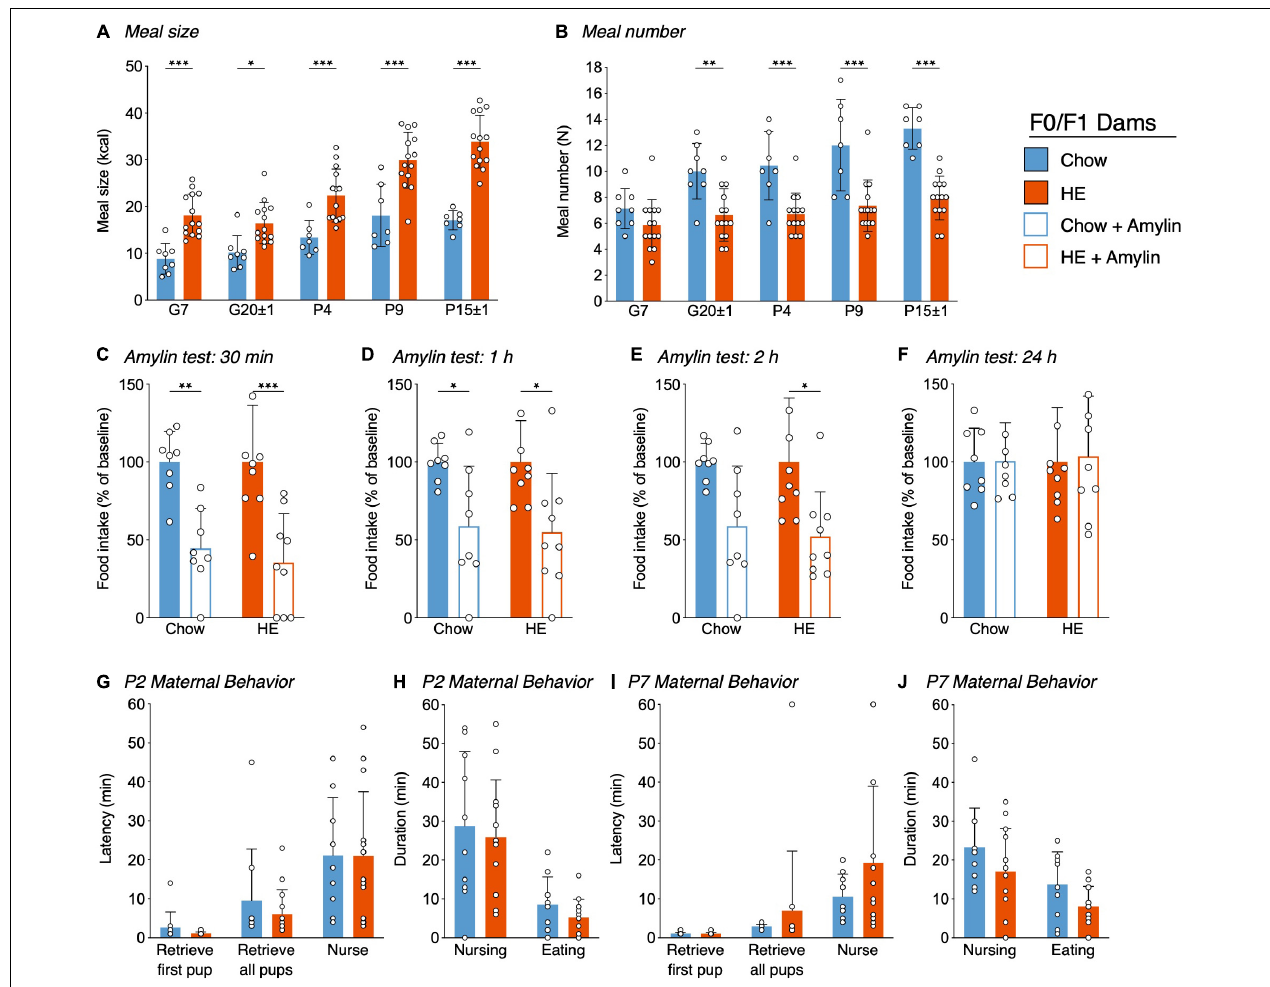
FIGURE 3 | Influence of HE-diet in obesity-prone and -resistant rat dams in filial generation 0 and 1 (F0/F1) on meal pattern, amylin sensitivity, and maternal behavior. Average meal size in kilocalories (A) and meal number (B) of pregnant and postpartum rat dams on chow or high energy (HE) diet on gestational day 7 (G7), G20 ± 1, postpartum day 4 (P4), P9, and P15 ± 1. (C–F) Food intake as percentage of baseline following a single dose subcutaneous amylin (20 µ g/kg) or vehicle (saline) injection in rat dams on gestational day 11 ± 2, 30 min (C) , 1 h (D) , 2 h (E) , and 24 h (F) after injection. (G–J) Pup retrieval test and 60 min maternal behavior home cage observation in dams on either chow or HE diet on P2 and P7. Latency to retrieve first pup, latency to retrieve all pups and latency to start nursing in minutes on P2 (G) and P7 (I) . Total nursing and eating duration in minutes on P2 (I) and P7 (J) . Data are represented as mean ± SD. * P < 0.05, ** P < 0.01, *** P < 0.001. N = 10 in chow group, N = 14 in HE